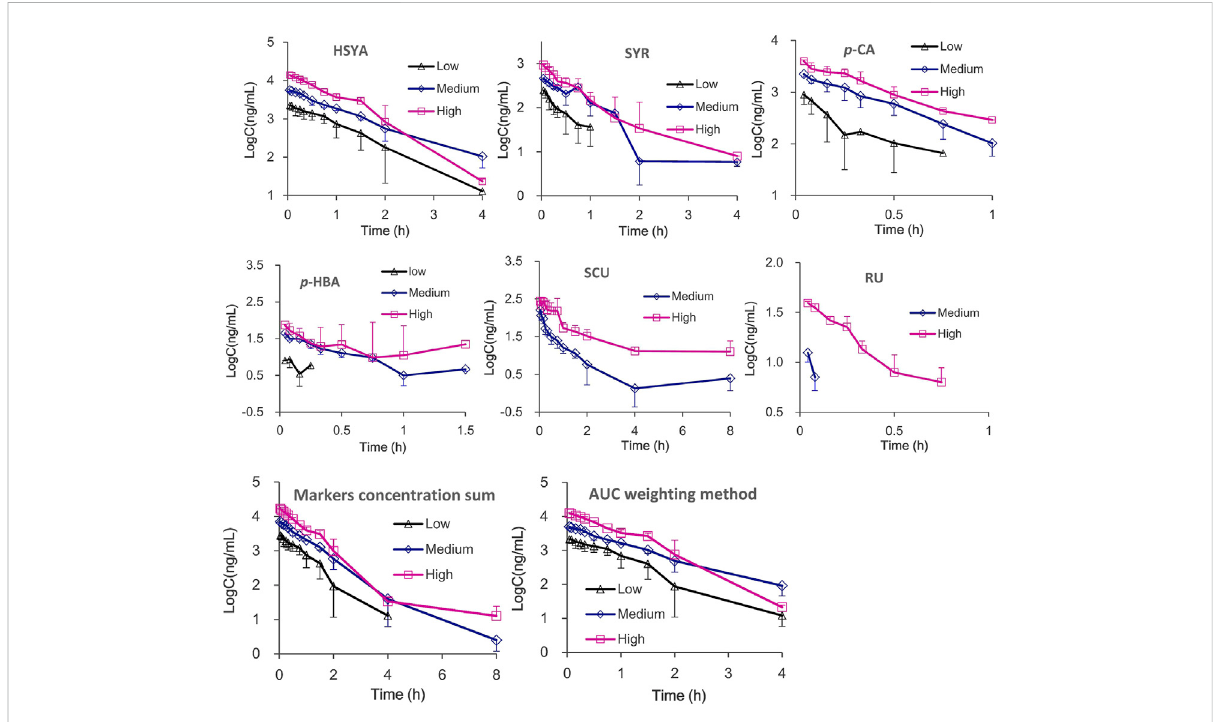
FIGURE 2 The mean plasma drug concentration – time curves and integrated plasma drug concentration-time curves of six ingredients after i.v., administration of SI with high (4 ml/kg, Mean ± SD, n = 3), medium (2 ml/kg, Mean ± SD, n = 3), and low (1 ml/kg, Mean ± SD, n = 4)